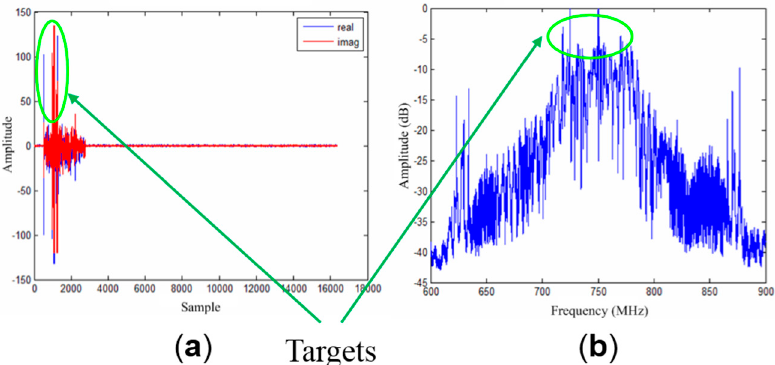
Figure 17. Bistatic scattered signal of the scene. ( a ) Bistatic scattered signal from one transmitted radar pulse, including the real (blue line) and imaginary (red line); ( b ) The sum of the frequency spectrum of the bistatic scattered signal from 100 transmitted radar pulses. Note that the scattered signal of the targets is in the green ellipses.